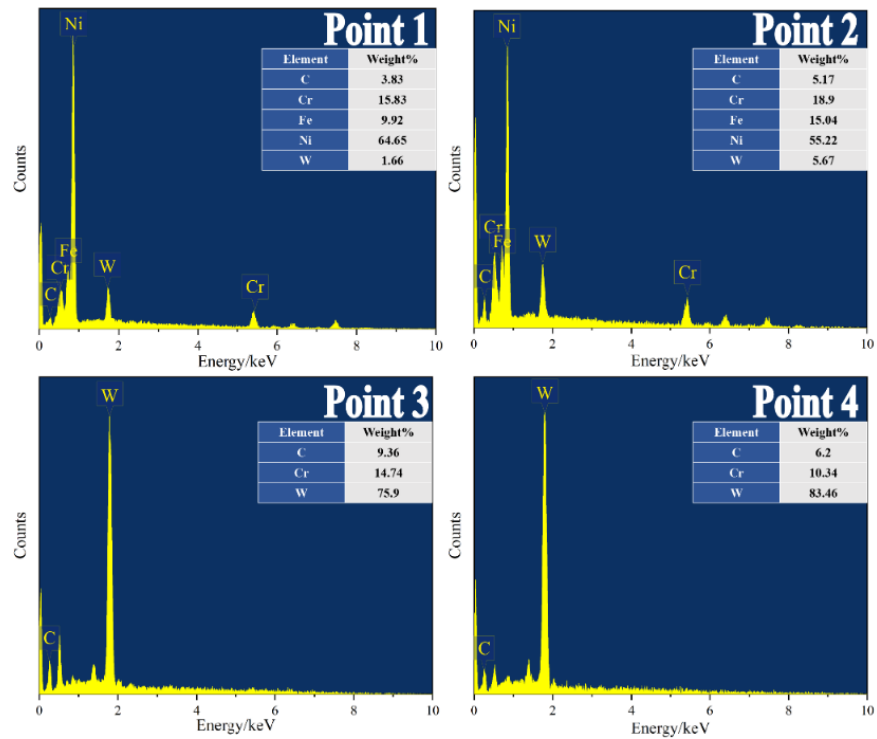
Figure 7. EDS results of the corresponding points of Points 1 – 4 in Figure 6.